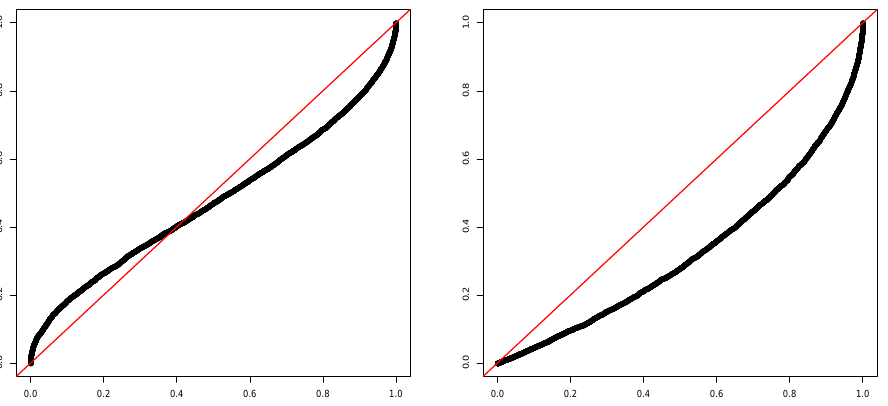
Figure 12. Comparison of asymptotic and bootstrap p -values under the null hypothesis and Negative Binomial innovations: ( left panel ) semiparametric bootstrap; ( right panel ) parametric bootstrap. The red dashed line represents the 45-degree line.